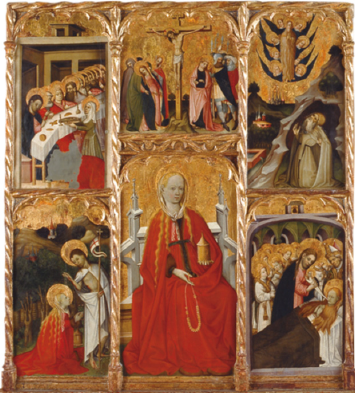
Figure 1. Bernat Martorell. Altarpiece of Saint Mary Magdalene from Perella , 1437–1452, Episcopal Museum of Vic.